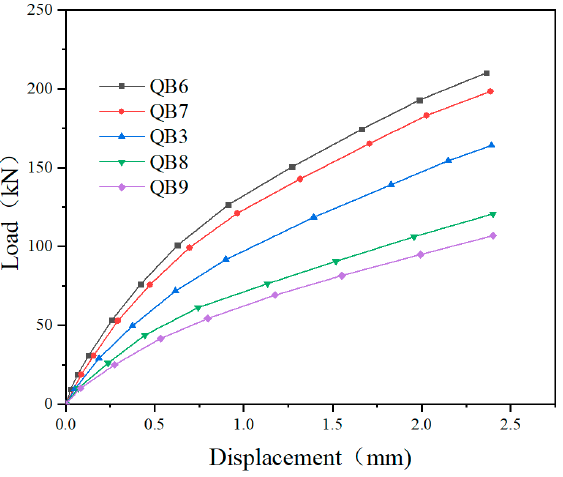
Figure 23. Load–displacement curves of the wallboard under different longitudinal spacings.